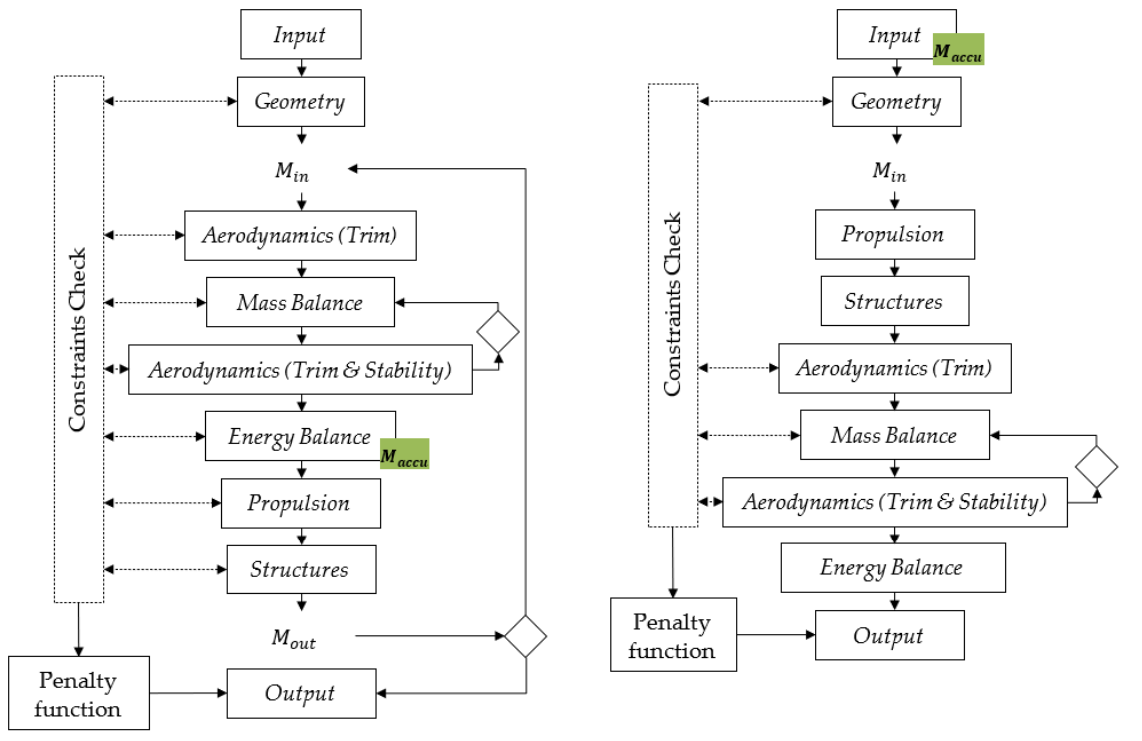
Figure 4. The complete design workflow of SD2020 ( left ) and the simplified version adopted in the present research ( right ).